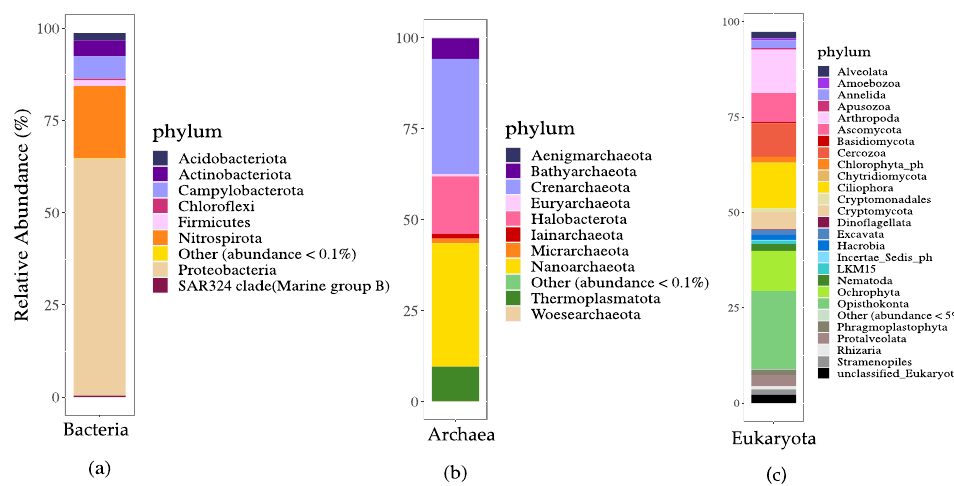
Figure 2. Relative abundance (% of total reads) of bacterial ( a ), archaeal ( b ), and eukaryote ( c ) taxa at the phylum level. For each domain, means of all samples are presented, with n = 37, n = 34 and n = 37, for Bacteria, Archaea and Eukaryotes, respectively.